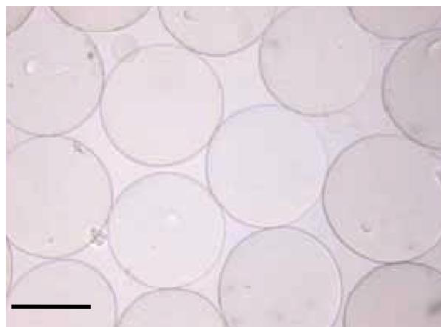
Figure 1. Alginate-poly(ethylene glycol) hybrid microspheres (alg-PEG-M) with an average diameter of 550 µm ± 5% SD. Scale bar: 400